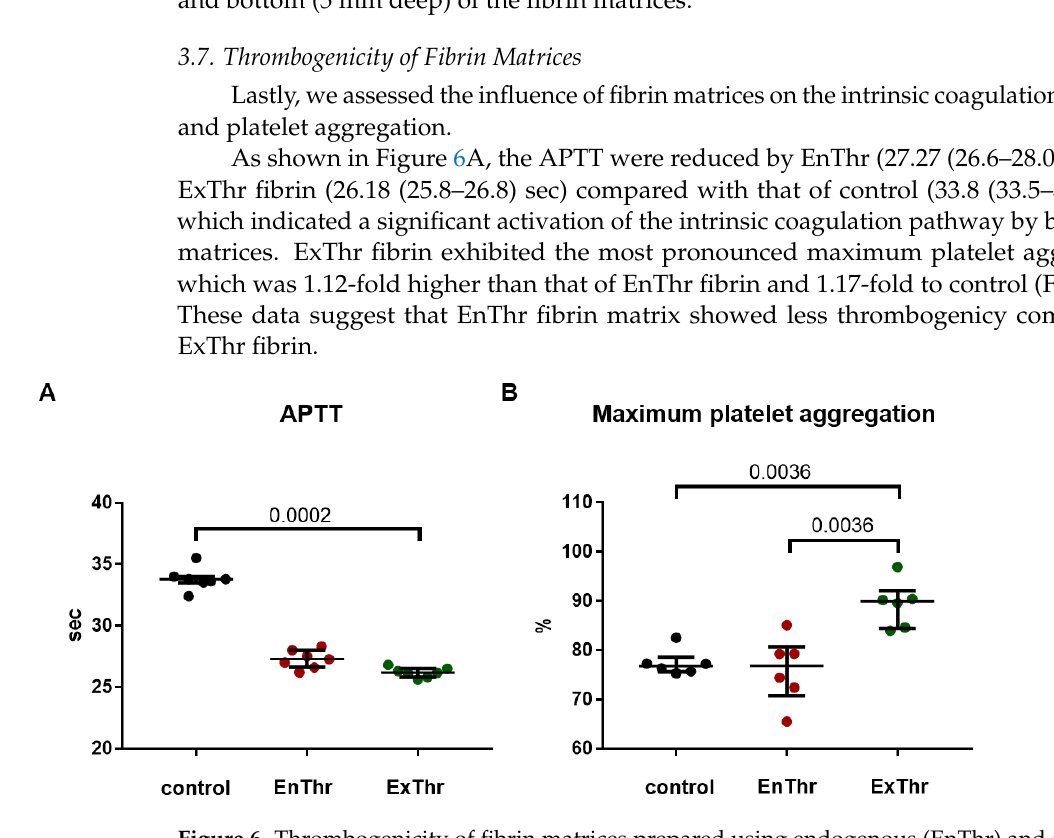
Figure 6. Thrombogenicity of fibrin matrices prepared using endogenous (EnThr) and exogenous (ExThr) thrombin: ( A ) activated partial thromboplastin time (APTT) and ( B ) maximum platelet aggregation. Center lines indicate the median, whiskers indicate the 25th and 75th percentiles.